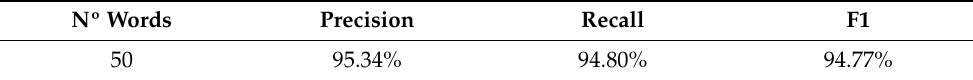
Table 4. Validation of sign